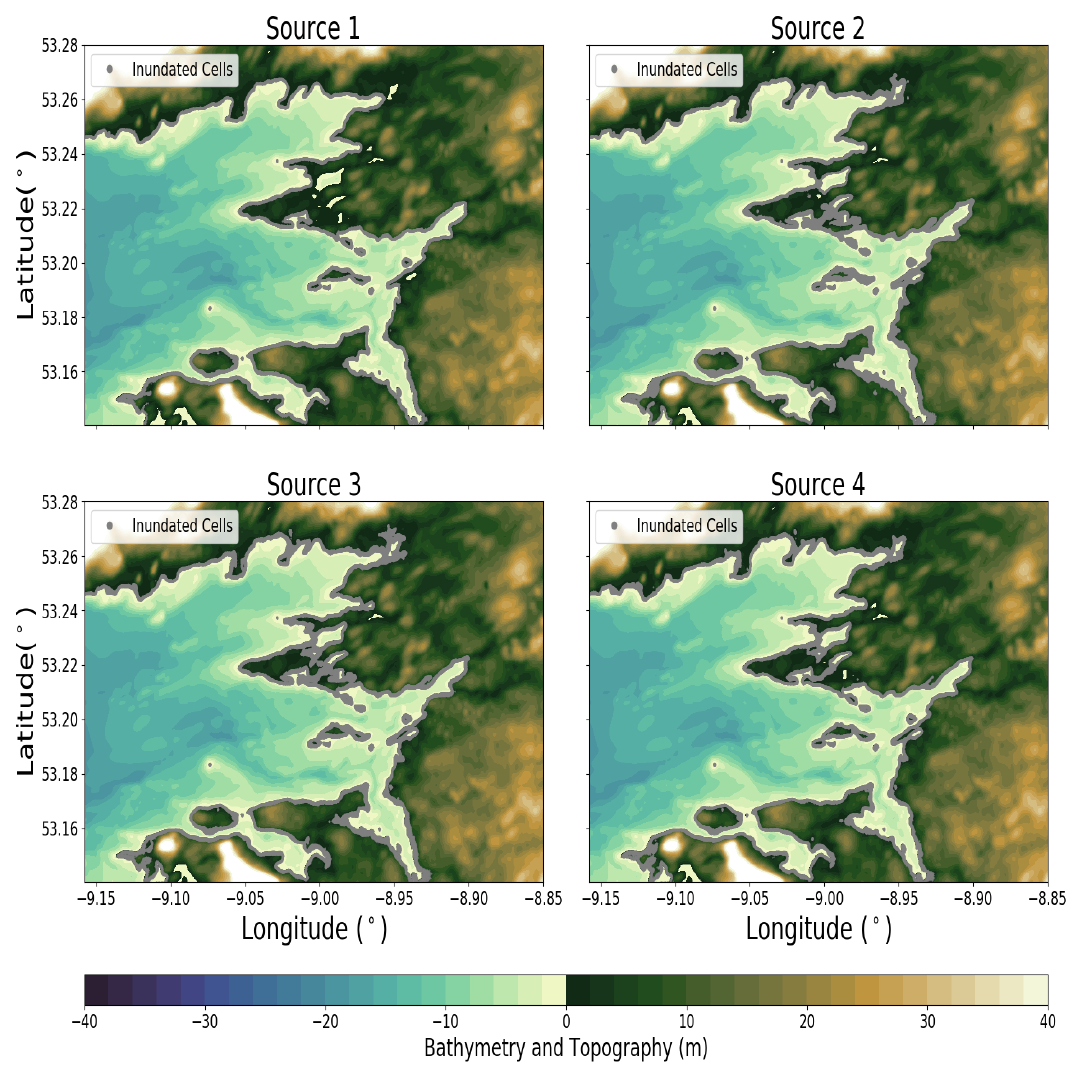
Figure 9. Inundation maps for Galway Bay for the various tsunami sources. The grey areas on the map are land values which were inundated during the